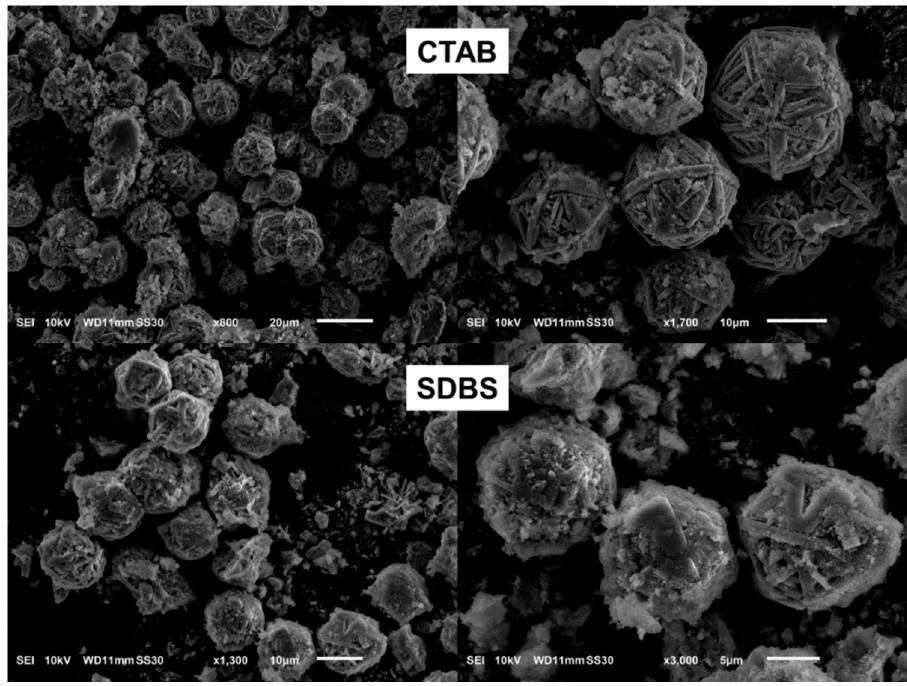
Figure 8. SEM images of DBM after hydrothermal treatment in the presence of 10 wt. % CTAB ( top row ) and 10 wt. % SDBS ( bottom row ).